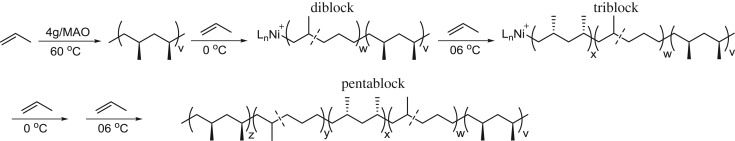
Synthesis of propylene-based tri- and pentablock copolymers.